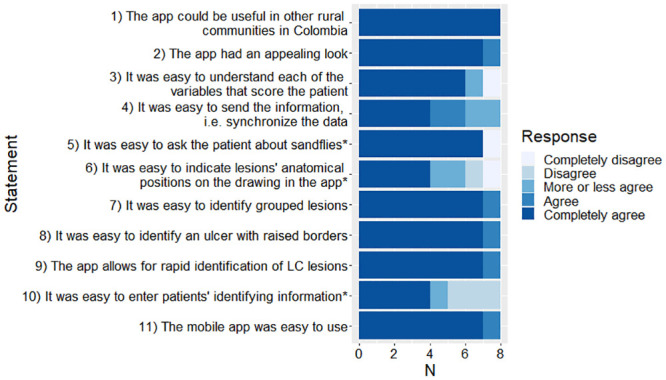
Results of questionnaire on usability.The median (range) score per question are: Q1, 1 (range 1–1); Q2, 1 (1–2); Q3, 1 (1–5); Q4, 1.5 (1–3); Q5, 1 (1–5); Q6, 2 (1–5); Q7, 1 (1–2); Q8, 1 (1–2); Q9, 1 (1–2); Q10, 2 (1–4); Q11, 1 (1–2). *Indicates statements that were posed in terms of difficulty of use, rather than ease of use. Here they have been inverted, in order to facilitate comparability across all the statements.